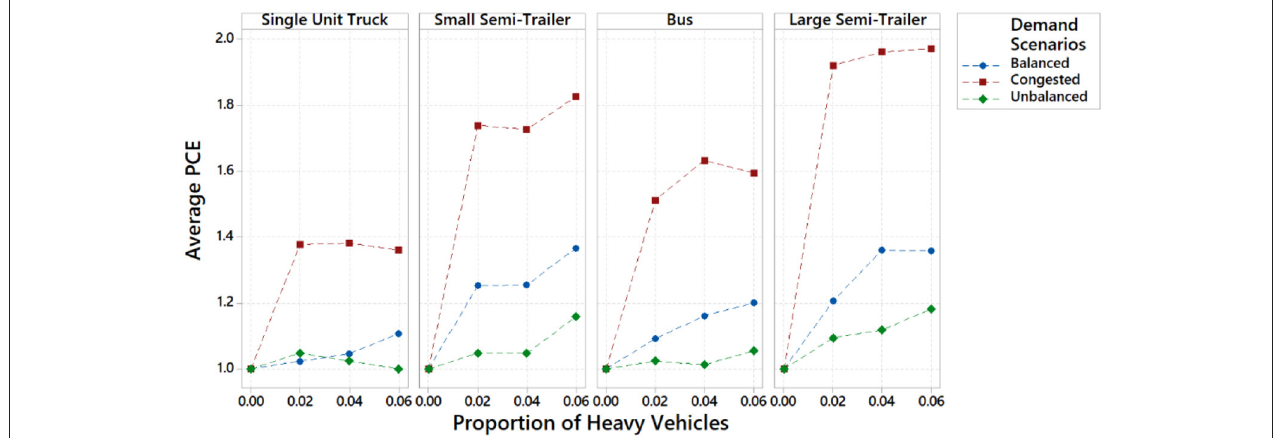
FIGURE 4 | Effect of demand scenarios on PCE for individual vehicle